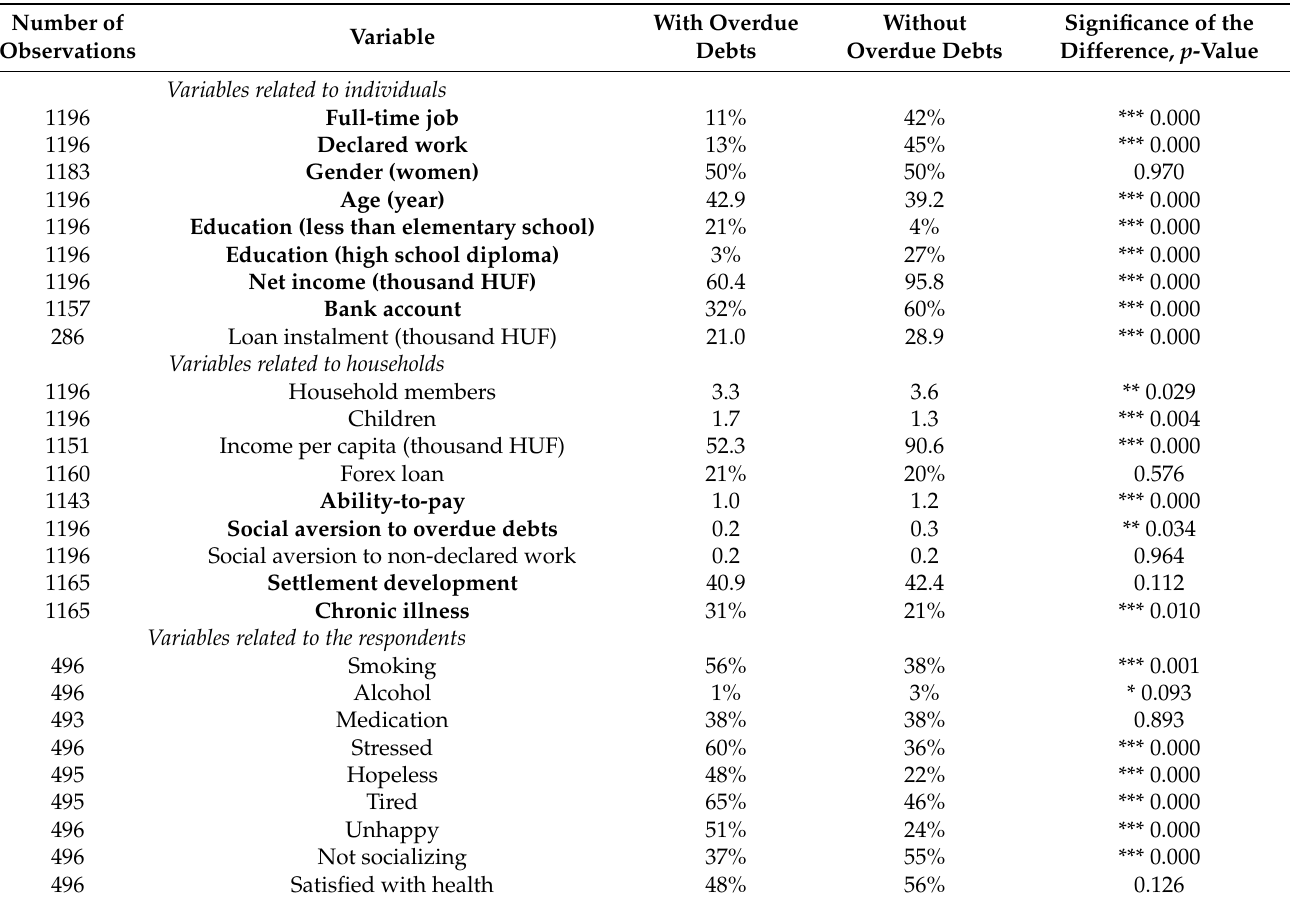
Table 2. Differences between individuals and households with and without overdue